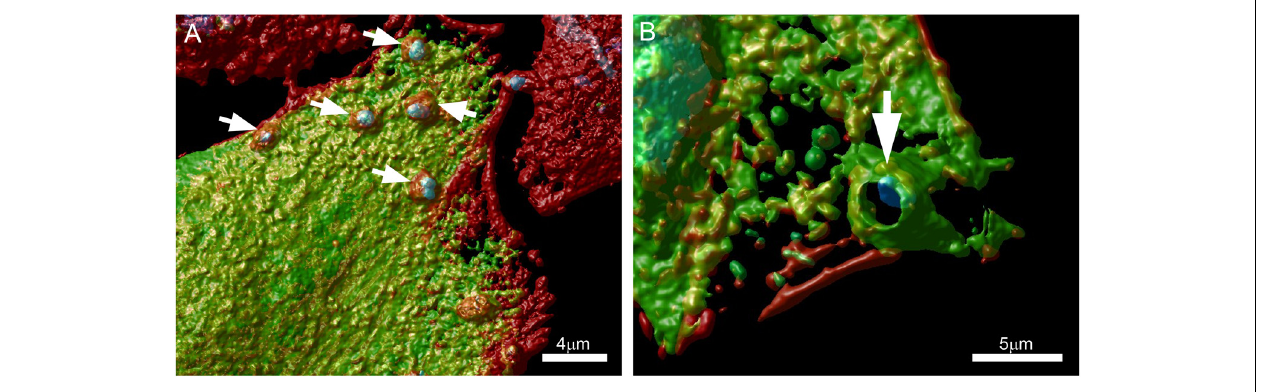
FIGURE 2 | Extracellular amastigotes (EAs) were incubated for 1 h with (A)Vero or (B) CHO cells transfected with a GFP tagged PKD (green) and stained with phalloidin-TRITC (actin) and DAPI (cells nuclei). Arrows